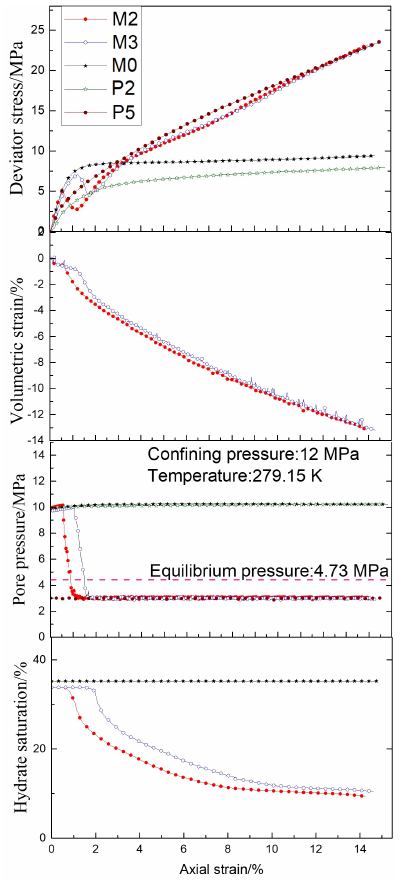
Figure1. Tissuetransglutaminase2(TG2)andcysticfibrosistransmembraneconductance(CFTR) Figure 4. Deviator stress, volumetric strain, pore pressure, hydrate saturation and axial strain modulation by probiotics administration invivo. CFTR ( A ) and TG2 ( B ) expression levels were evaluated in the small intestine of Balb/c fed third-generation gluten-free mice, treated (Glia) or tendencies of the various specimen under different shear nottreated(CTRL)withgliadin,inthepresenceorabsenceofP1orP2,atbothmRNA(leftpanels) andprotein(rightpanels)levels. Histogramsrepresentmean ± standarddeviation(SD)oftriplicate sample; **** p < 0.0001; ** p < 0.01; ns = not significant; β -actin was used as loading control in the immunoblots.